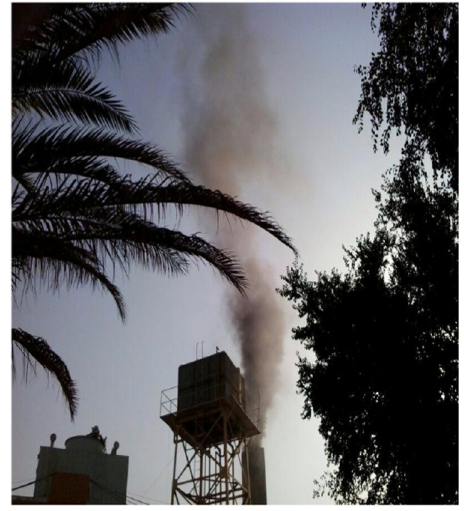
Figure 1: The incinerator of Al - Sadr